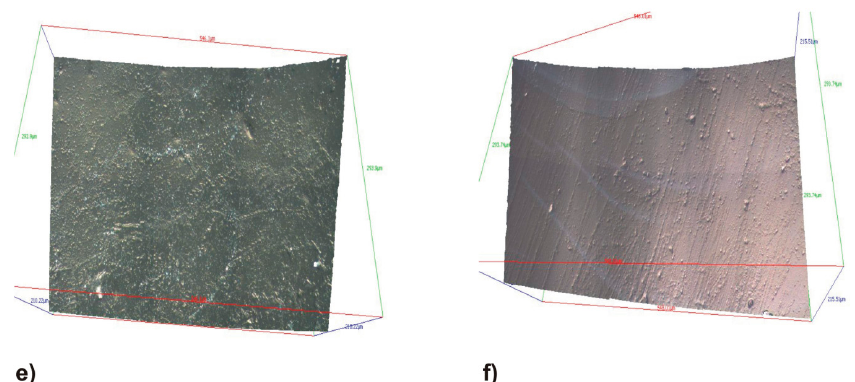
Figure 1. Three-dimensional surface images (stereolithographic (STL) files of the surface scan of the occlusal surfaces made from the different materials before and after chewing simulation: Lava Ultimate ( a ) before, ( b ) after; Vita Enamic ( c ) before, ( d ) after and Vita Suprinity ( e ) before, ( f ) after. 2.2. Vertical Loss of the Full Ceramic CAD/CAM Crowns and the Natural Antagonists The highest main abraded cusp wear (vertical loss) of the full ceramic CAD/CAM crowns after 1,200,000 chewing cycles was in the Lava Ultimate group 21.1 μ m (interquartile range 18.6–24.5 μ m),